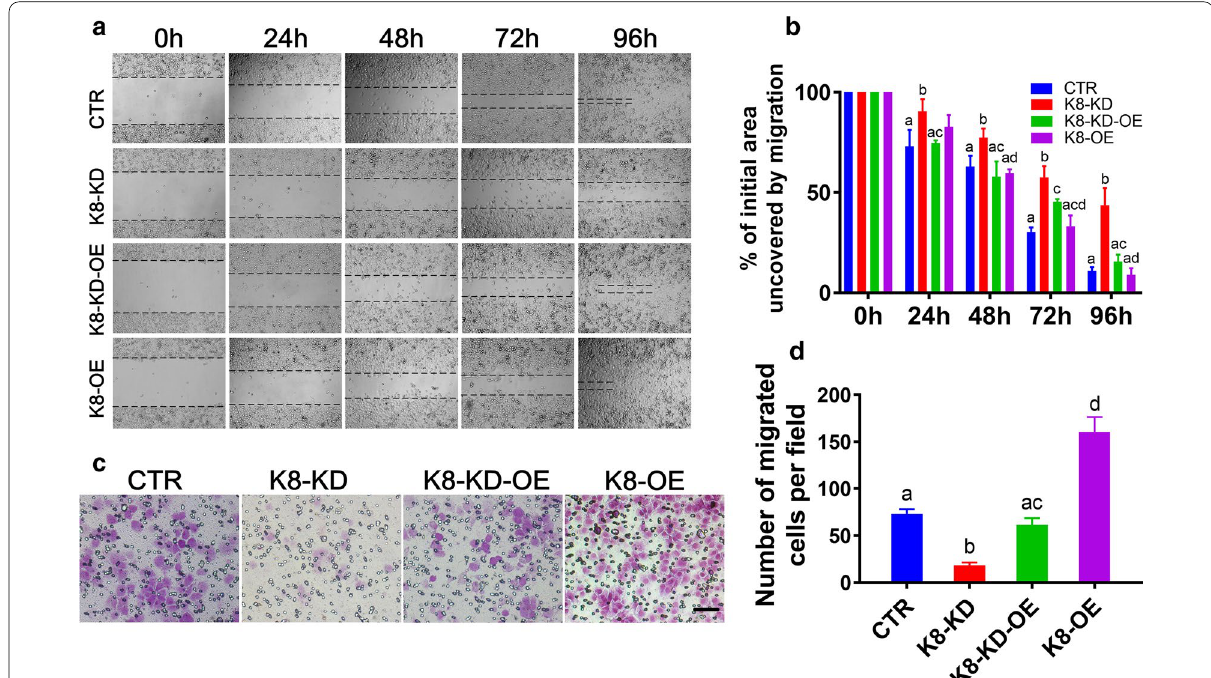
Fig. 4 Human KBTBD8 was important for the migration of EOC cells. a , b Wound healing assays showed that the closure ratio in K8‑OE group was more than in control group; whereas the closure ratio in K8‑KD‑OE group was more than K8‑KD group while close to control group. Representative images at 0 h, 24 h, 48 h, 72 h, and 96 h were shown. Percentage of initial scratched area uncovered by migrated cells at 24 h, CTR vs. K8‑KD vs. K8‑KD‑OE vs. K8‑OE, 72.99% vs. 90.38% vs. 74.58% vs. 82.79%; at 48 h, 62.95% vs. 77.26% vs. 57.82% vs. 59.50%; at 72 h, 30.29% vs. 57.35% vs. 45.35% vs. 33.13%; at 96 h, 10.90% vs. 43.61% vs. 15.54% vs. 8.896%. c , d 3‑dimensional migration assay showed that the number of migrated cells in K8‑OE group was more than in control group, whereas the number of migrated cells in K8‑KD‑OE group was more than in K8‑KD group while close to control group (Number of migrated cells per field, CTR vs. K8‑KD vs. K8‑KD‑OE vs. K8‑OE, 73 vs. 19 vs. 62 vs. 160). Scale bar, 50 μm. Different characters above the column between groups indicate significant